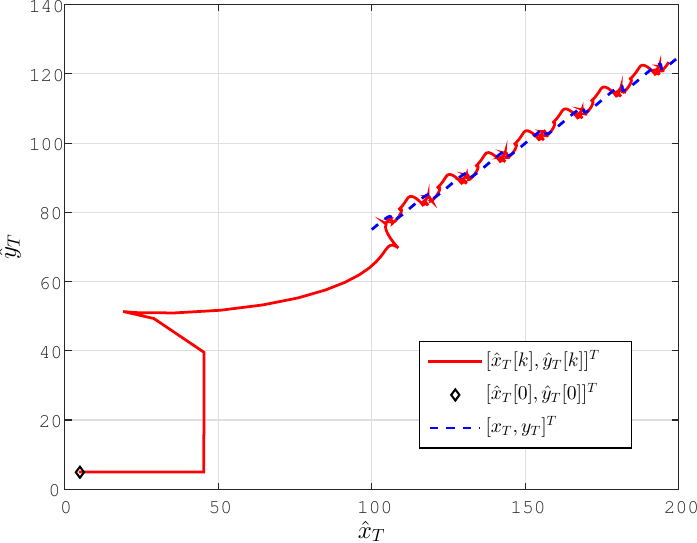
Figure 6. Lateral coordinate estimates ( ˆ x T [ k ] , ˆ y T [ k ]) (m) for the drifting target